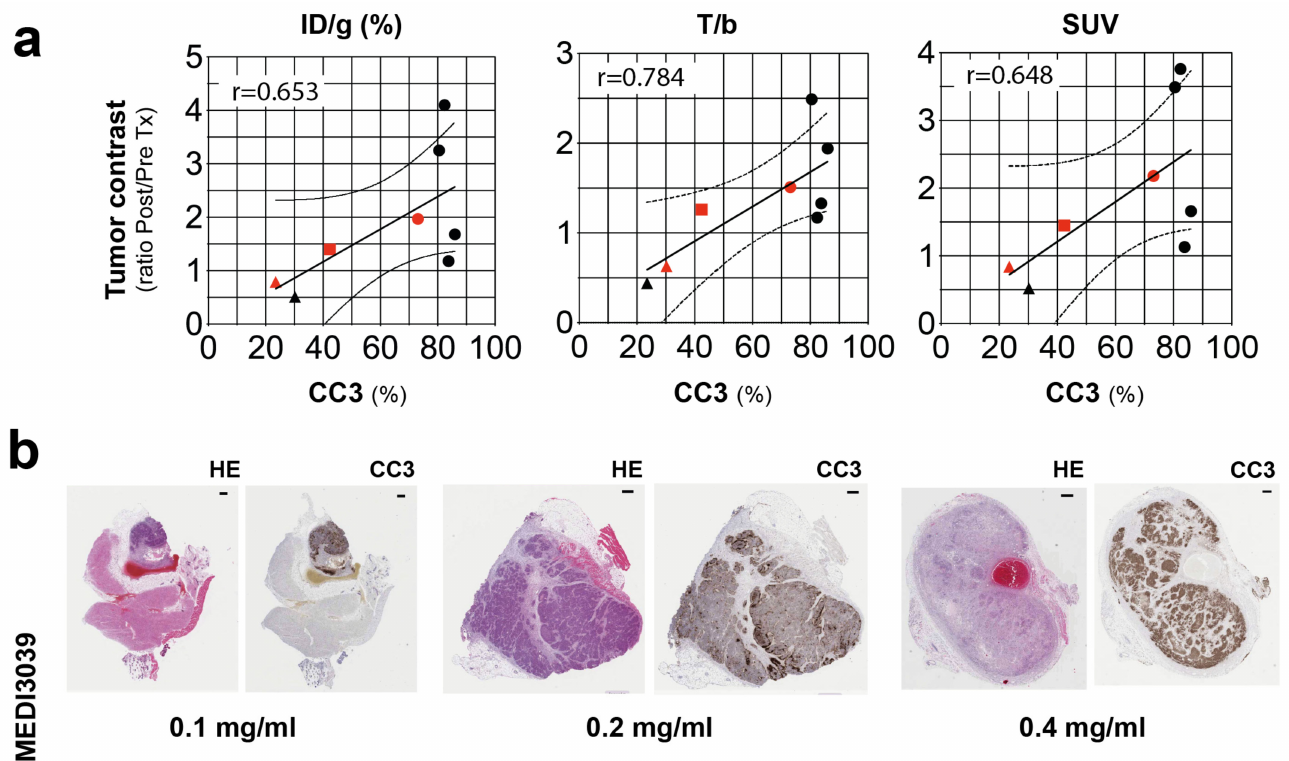
Figure 5. Correlation analysis of tumor PET signal with the histological marker of apoptosis, CC3 staining (%). ( a ) Pearson correlation values (r) are shown (top left corner of charts) for tumor contrast, expressed as ID/g, %, T/b, and SUV, 2 h post-administration of 68 Ga-C2Am, vs. levels of tumor cell death (CC3, %). CC3 levels were estimated from two sections (200 µ m apart) from MEDI3039-treated COLO205 tumors. Tumor contrast is expressed as the signal ratio, post/pre-treatment. COLO205 tumor-bearing mice (N = 8), treated with MEDI3039 (0.1—triangles, 0.2—squares, or 0.4 mg/kg, circles, 24 h, i.v.) ( b ) CC3 staining is shown for representative tumor sections corresponding to red symbols in ( a ). Two-tailed, r values are shown in ( a ). CC3, cleaved caspase 3; T/b, tumor-to- blood